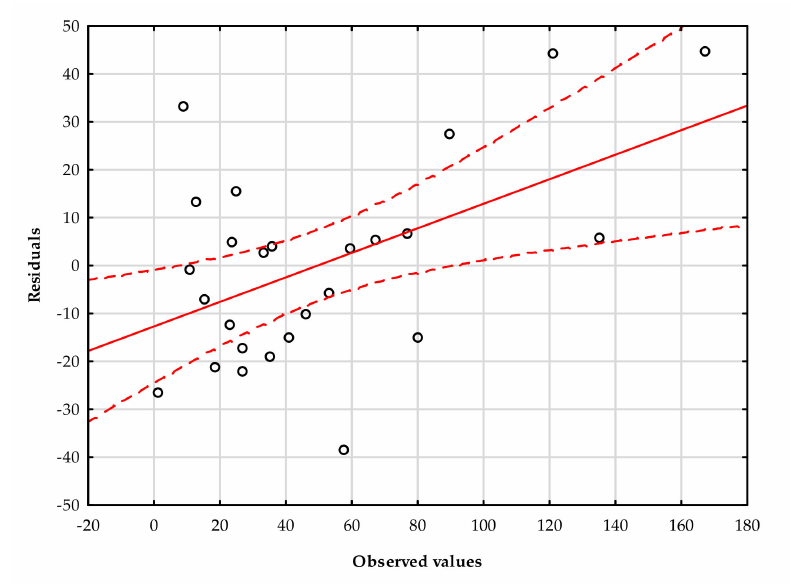
Figure 12. Diagram of the predicted values versus residual values for the model for estimating Q MED in mountain catchments of the Upper Vistula basin; dashed lines are the confidence intervals for α = 0.05, while points represent residuals of the model (distance between observed Q MED values and those predicted by the model (Equation (3)) of Q MED ).